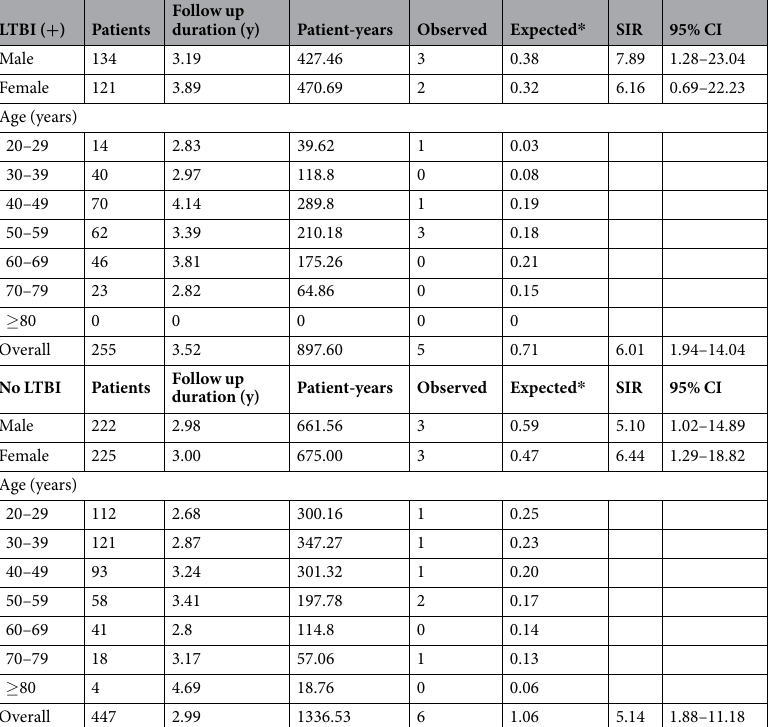
Table 4. The observed numbers and standardized incidence ratio of patients with active TB. * To estimate ‘expected TB’ the sex and age specific TB patient notifications in 2011 were extrapolated from Korea centers for disease control and prevention. TB,tuberculosis; SIR, standardized incidence ratio; CI, confidence